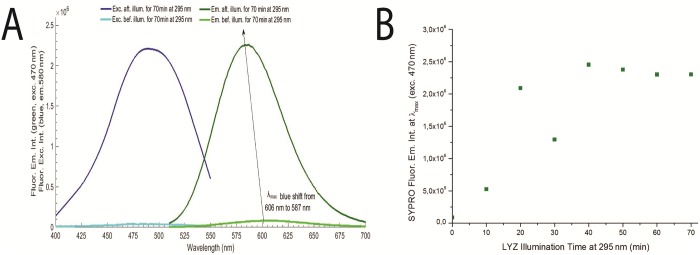

A) Monitoring LYZ with SYPRO® Orange spectra before and after 70 min 295 nm excitation of LYZ at 20°C, with excitation slit fixed at 0.5 mm (1.0 μW). Fluorescence intensity of SYPRO® Orange was fixed at 580 nm and excitation at 470 nm. B) SYPRO® Orange emission intensity (excitation wavelength fixed at 470 nm) for every 10 min of LYZ 295 nm excitation for 70 min.